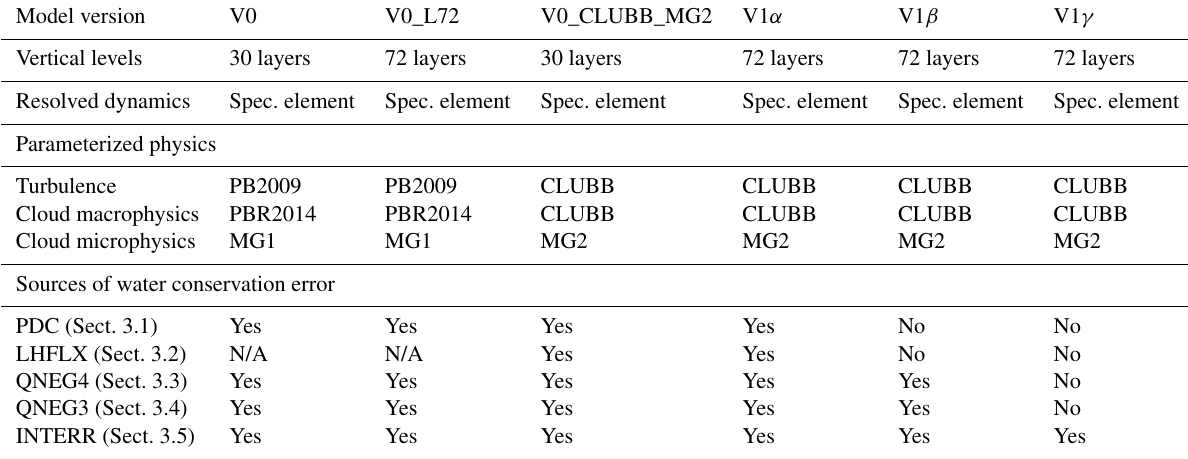
Fig. 1a for V0 and Fig. 1b for V1. In each flow chart, the blue stadium shape refers to the resolved-scale dynamics and transport, and the diamond refers to the exchange of mass and energy with other model components (e.g. land and ocean) via the coupler. The rectangular cells are parts of the physics package that describe the sub-grid-scale physical and chem- ical processes that operate on a single vertical column. The coloured cells indicate parts of EAM that affect the concen-